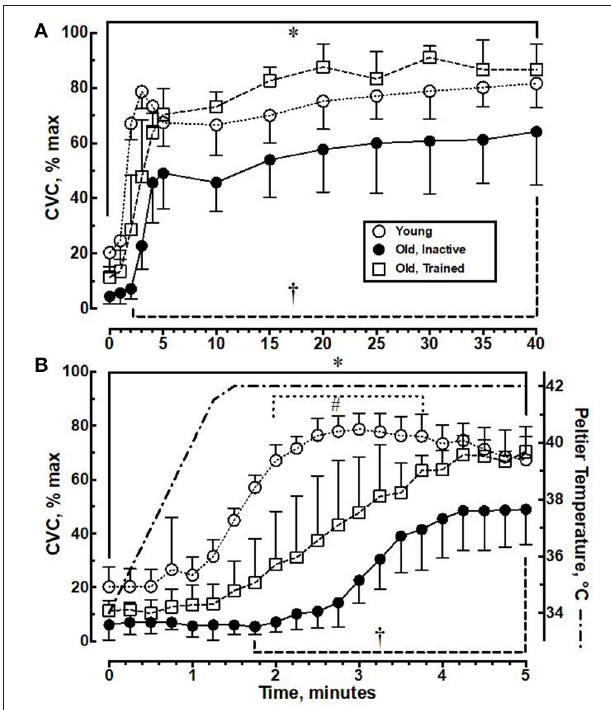
FIGURE 1 | (A) Cutaneous vascular conductance (CVC) changes, expressed as a percentage of maximal CVC (CVC % max), during 40min of local skin heating to 42 ◦ C. (B) The first 5min of CVC data replotted to illustrate the initial time course of change following the onset of local heating and the corresponding Peltier temperature. Values represent Mean ± 1 SD for 10 young, 8 old- trained, and 8 old- inactive subjects. * p < 0.05 young different from older- inactive, † p < 0.05 older- trained different from older- inactive. # p < 0.05 young different from older- trained.